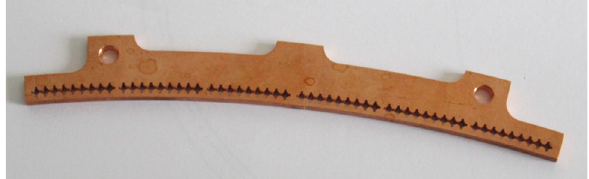
Fig. 15 Fiber holder produced with wire erosion. Note the pattern of diagonally aligned square holes. One holder covers an angular range of 23 . 5